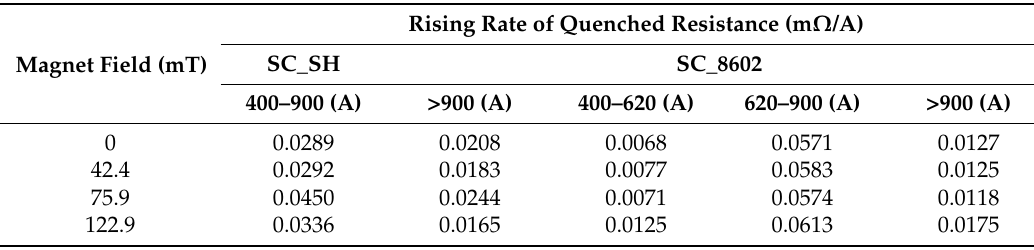
Table 2. Distribution of Rising Rate of Quenched Resistance.